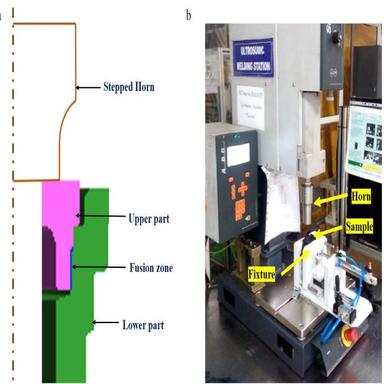
(a) Schematics of parts arrangement; (b) USW experimental setup.